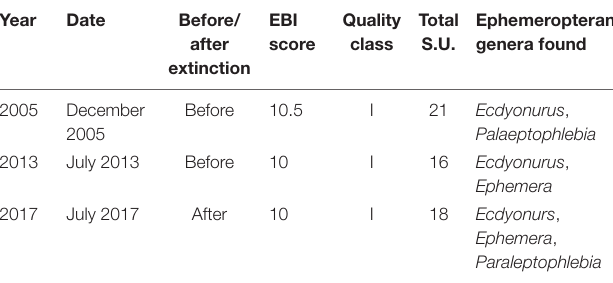
TABLE 3 | Results of the extended biotic index (EBI) assessment in different years along the same transect of the stream where the reintroduction was